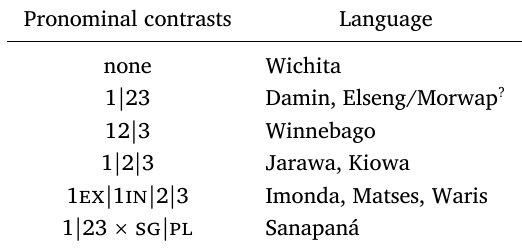
Typology of pronoun systems according to Harbour (2015, p.